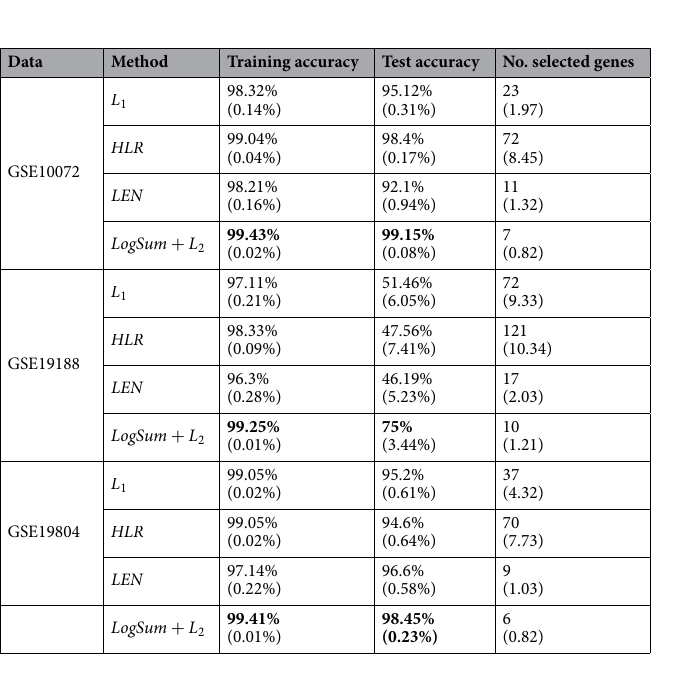
Table 5. Training and test accuracy and number of selected genes of three lung cancer datasets in four methods. Numbers in parentheses are the standard deviations and the best results are highlighted in